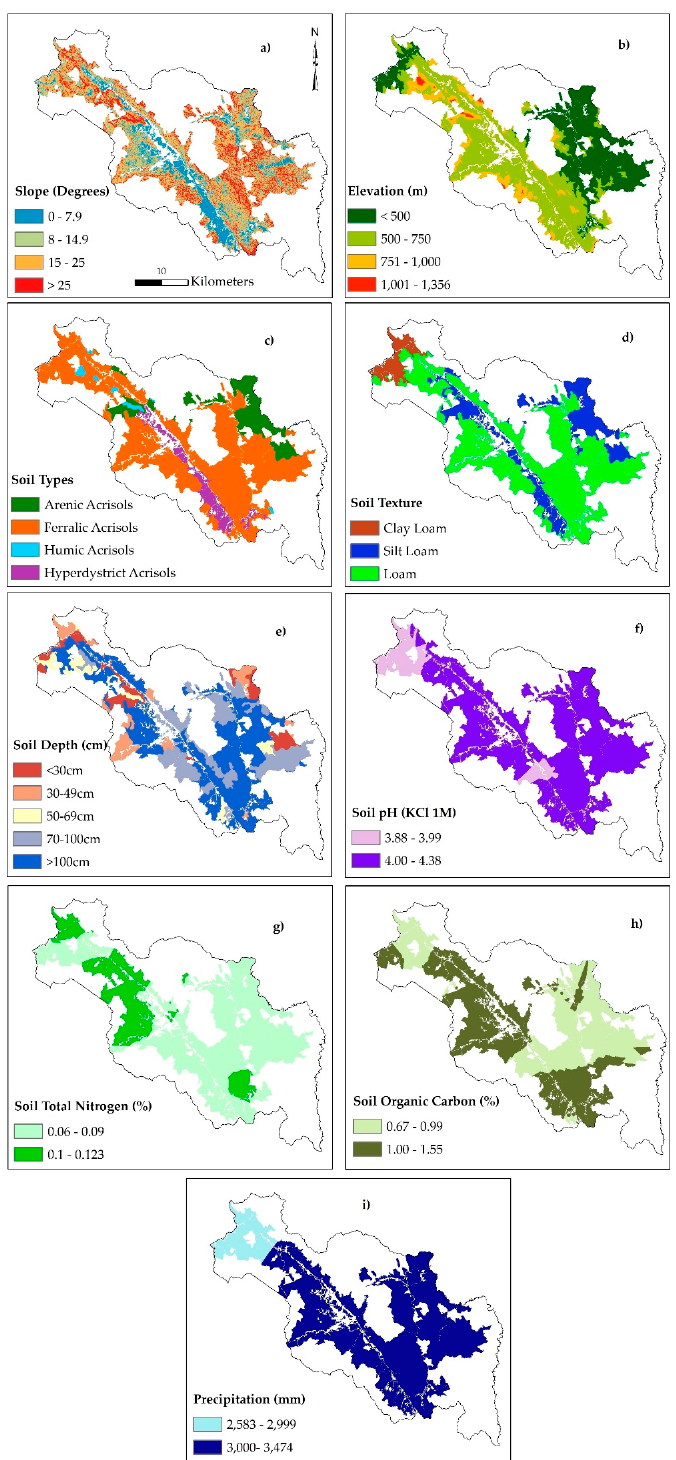
Figure 4. Geographic distribution of physical criteria in A Luoi district: ( a ) slope; ( b ) elevation; ( c ) soil types; ( d ) soil texture; ( e ) soil depth;( f ) pH value; ( g ) soil total nitrogen; ( h ) soil organic carbon; and, ( i ) annual precipitation.